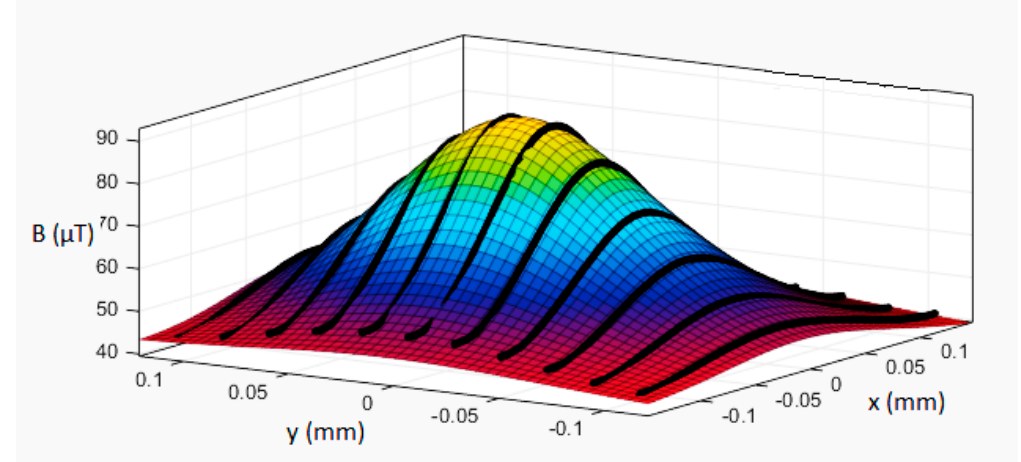
Figure 4. Approximation of ME8 induction of magnetic field distribution (black lines—measurement results) to the model (4). Coordinates set: ( x 0 , y 0 , z 0 ) = (0, 0, 140) mm, β = 0°, and φ = 0°. Three-dimensional graph of the distribution of B field values. Sensors 2018 , 18 , x FOR PEER REVIEW 8 of 13